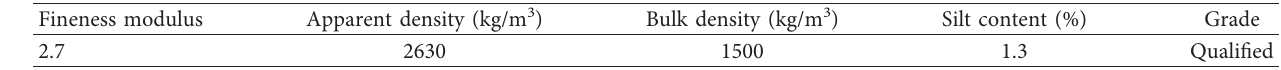
Table 2: Key technical indexes of sand.